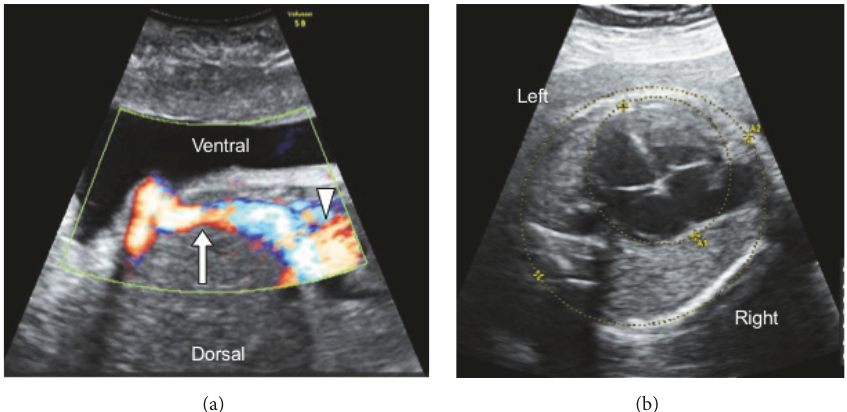
Figure 1: Prenatal ultrasound findings of a patient with absent ductus venosus. (a) The umbilical vein (arrow) directly flows into the right atrium (arrowhead). (b) The cardiothoracic area ratio was 36.5%.